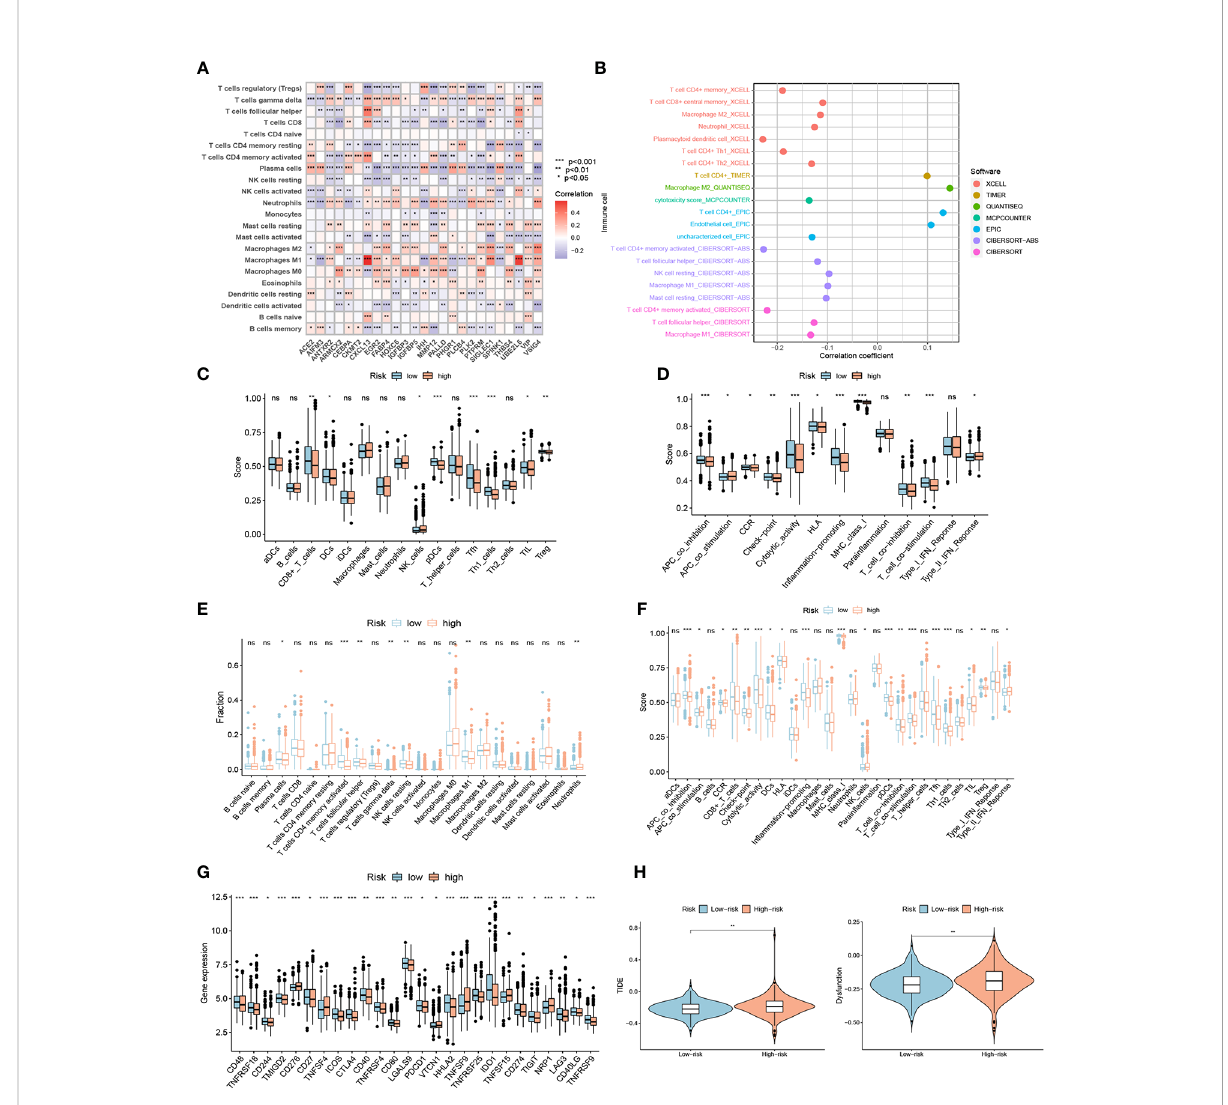
FIGURE 8 The immune landscape of high- and low-risk groups. (A) Heatmap showing a close correlation between genes in the signature and immune cells. (B) Correlation analysis showed that the overall risk score was negatively correlated with immune in fi ltration in TCGA samples. Different contributions of immune cell in fi ltration and immune function in distinct risk groups based on ssGSEA algorithm (C-D) and CIBERSORT algorithm (E-F) . (G) Different expression of immune checkpoint genes in high- and low-risk groups. (H) TIDE scores and Dysfunction scores of distinct risk groups based on TCGA samples. ***P < 0.001; **P < 0.01; *P < 0.05; ns P ≥